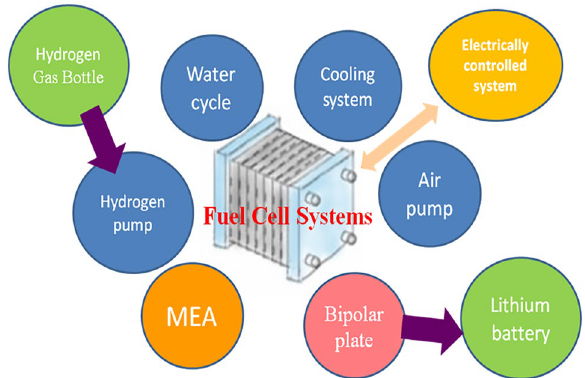
Figure 1. Components of fuel cell system.